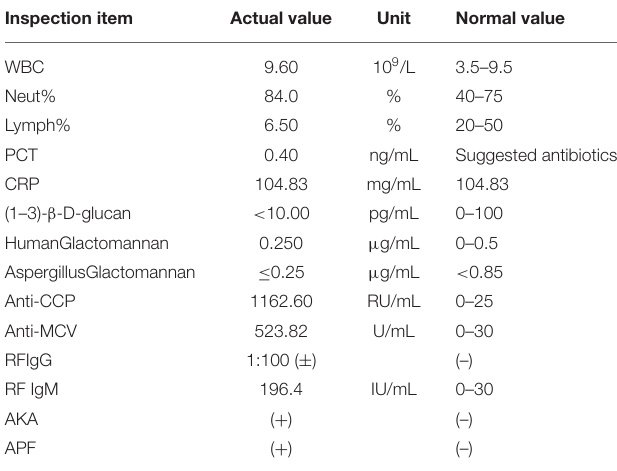
TABLE 1 | Test results after